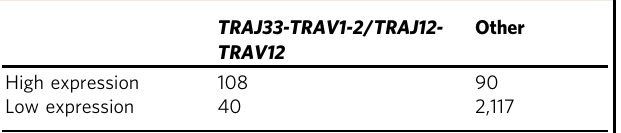
Fig. 6 The T cell scRNA-seq data. a The number of detected gene fusions by the fi ve methods. b The percentages of V(D)J recombinations in fusions detected by the fi ve methods. c The expressions of SLC4A10 shown in the tSNE plot of all T cells. d The cells with TRAJ33-TRAV1-2 and TRAJ12-TRAV1-2 colored in the tSNE plot. e , f The barplots of numbers of cells with the TRAJ33-TRAV1-2 ( e ) and TRAJ12-TRAV1-2 ( f ) recombinations by different algorithms. Source data are provided as a Source Data fi le. Table 1 The contingency table between the TRAJ33-TRAV1- 2/TRAJ12-TRAV1-2 fusion and the expression of SLC4A10 .